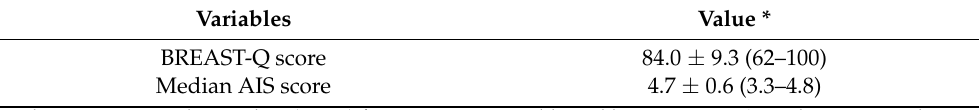
Table 2. Satisfactory outcomes using the BREAST-Q and